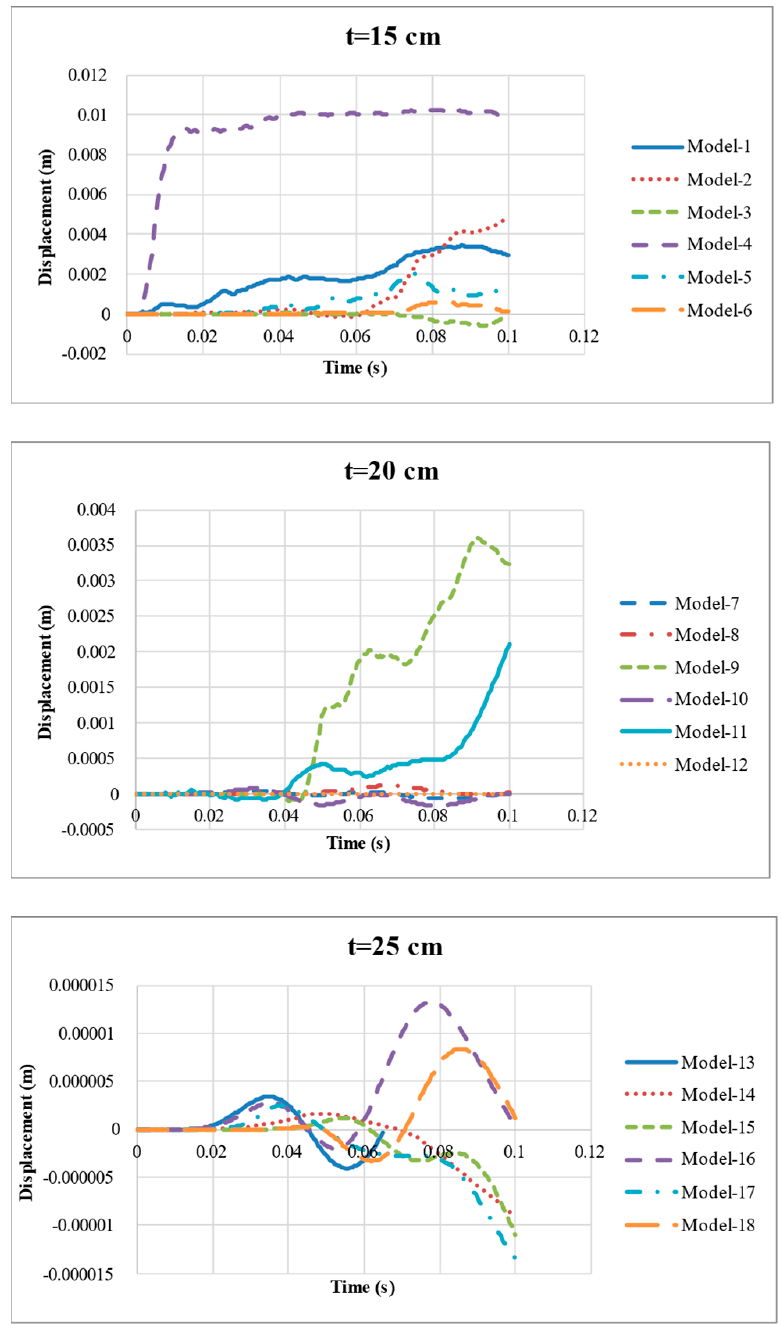
Figure 10. Time–displacement diagrams for wall thicknesses of 15, 20, and 25 cm.